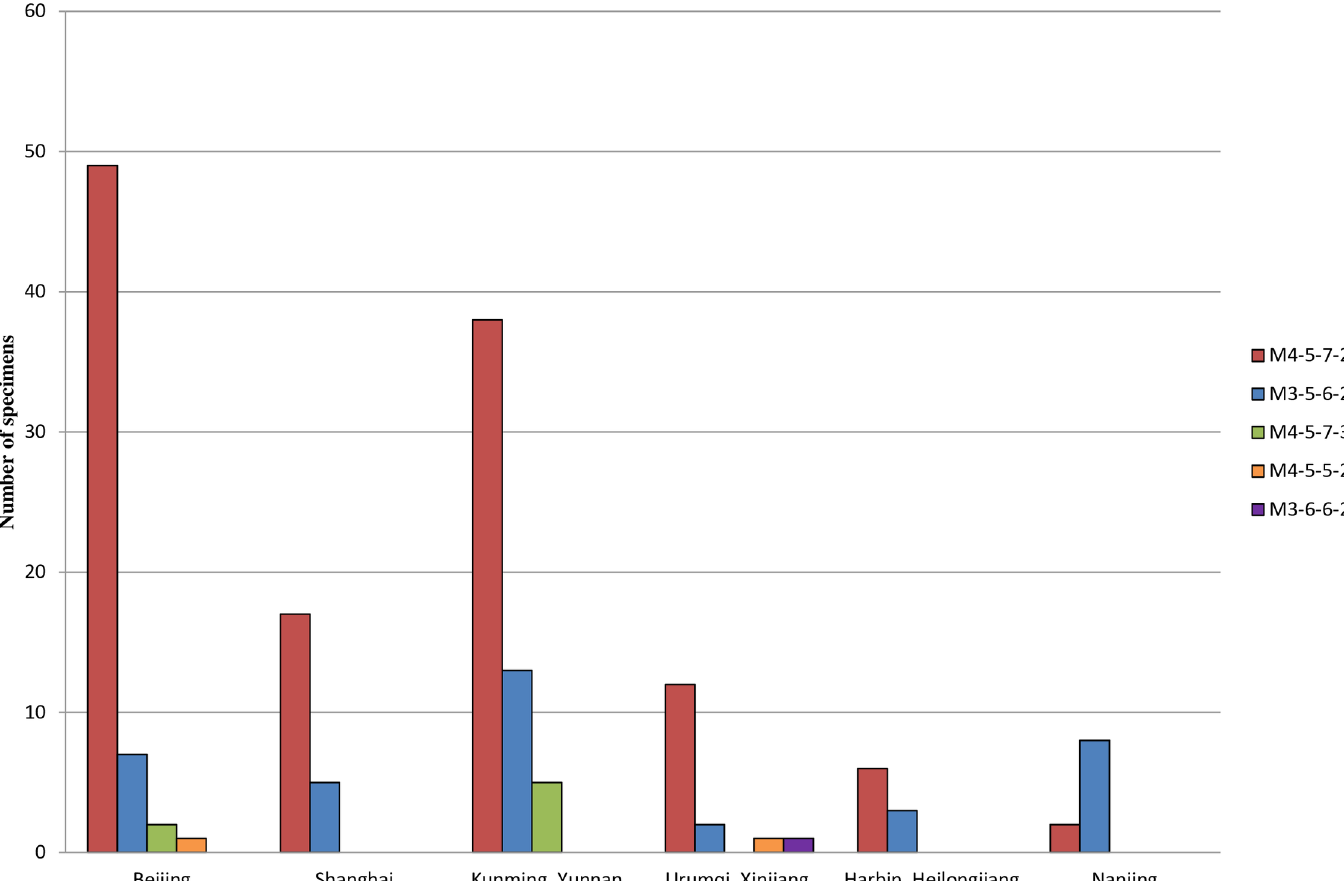
Fig 2. Genotype distribution across different sites. Different colors are used to represent the genotypes observed at different sites.